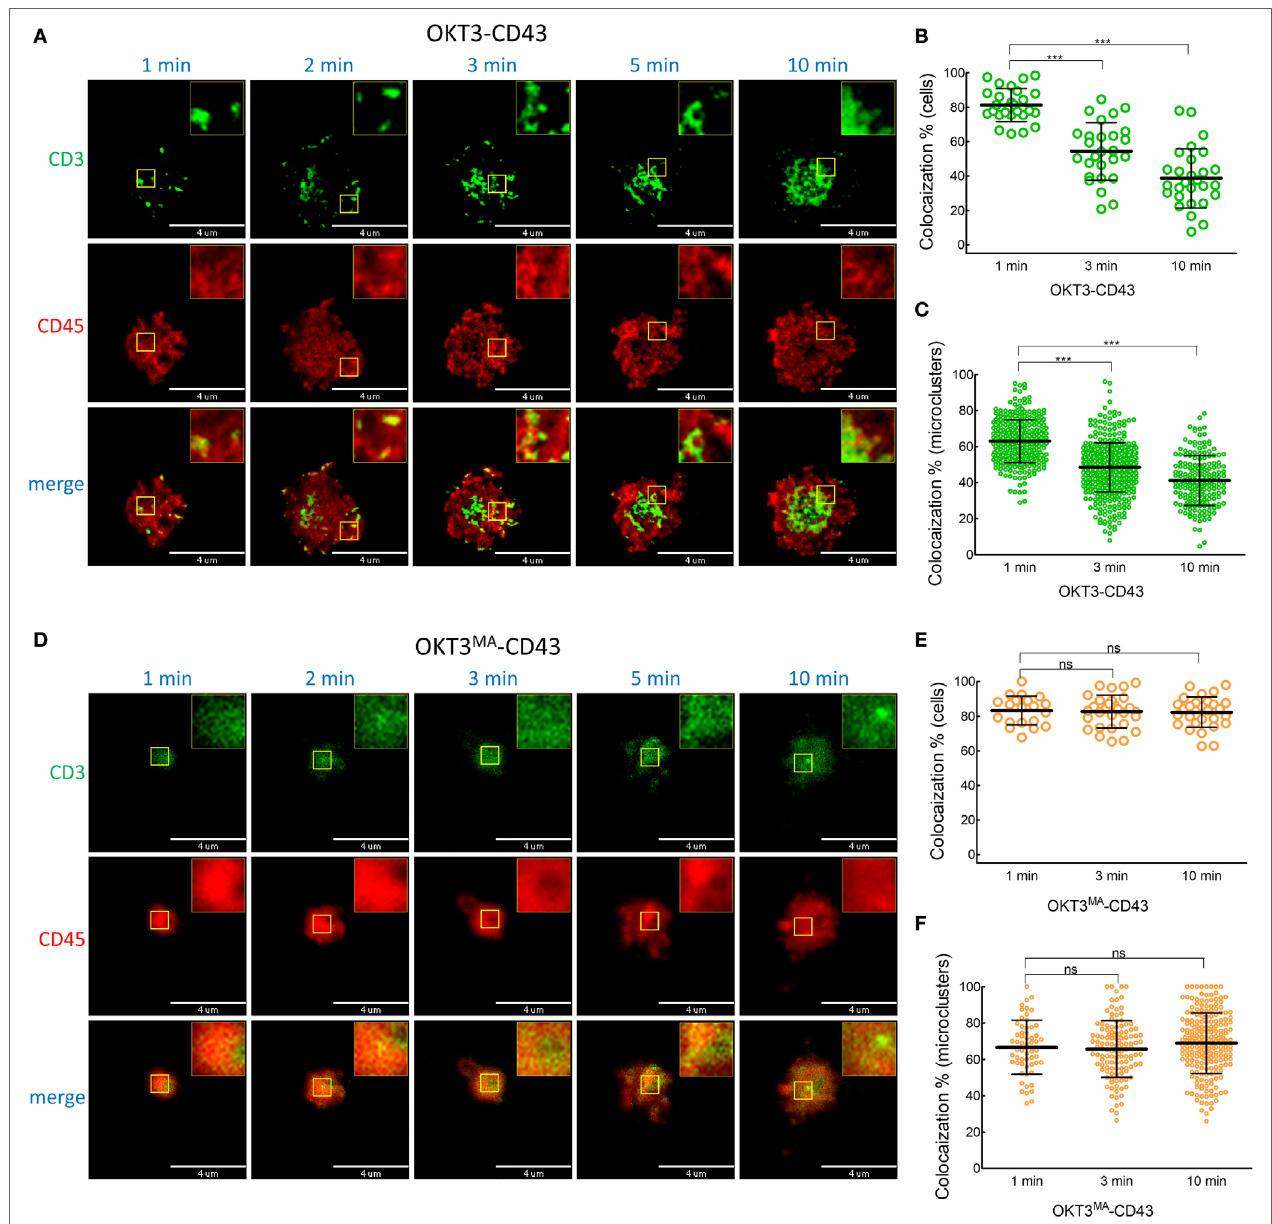
FigUre 5 | Co-localized CD45 and CD3 by elongated ligands start segregation only by productive activation. (a) A representative cell was imaged for CD3 (green) and CD45 (red) by TIRF microscopy at 1, 2, 3, 5, and 10 min after contact with OKT3-CD43 on a planar lipid bilayer. (B) Co-localization percentage between CD3 and CD45 measured by intensity of overlapped pixels for whole Jurkat cell activated by OKT3-CD43 ( n = 27 cells, representative of three independent experiments). (c) Co-localization percentage between CD3 and CD45 measured by intensity of the overlapped pixels for individual microclusters obtained from Jurkat cells activated by OKT3-CD43 ( n = 27 cells, representative of three independent experiments). (D) A representative cell was imaged for CD3 (green) and CD45 (red) by TIRF microscopy at 1, 2, 3, 5, and 10 min after contact with OKT3 MA -CD43 on a planar lipid bilayer. (e) Co-localization percentage between CD3 and CD45 measured by intensity of overlapped pixels for whole Jurkat cell activated by OKT3 MA -CD43 ( n = 20, 29, and 30 cells for the three time points, representative of three independent experiments). (F) Co-localization percentage between CD3 and CD45 measured by intensity of the overlapped pixels for individual microclusters obtained from Jurkat cells activated by OKT3 MA -CD43 ( n = 17 cells, representative of three independent